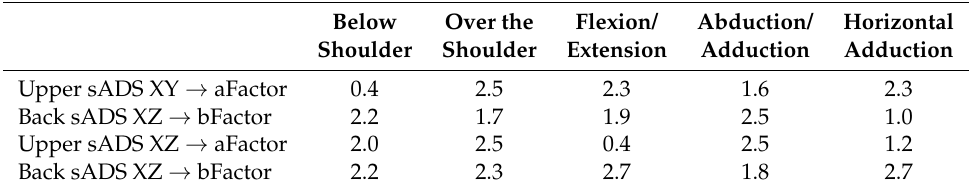
Table 7. Weights used in Equation (A11) to reduce the estimation error. Below